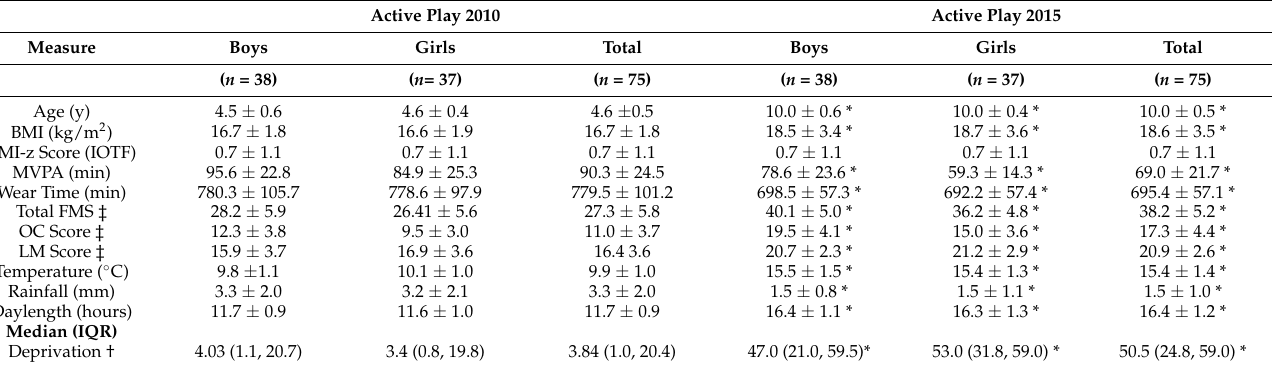
Table 1. Baseline (Active Play 2010) and Follow-Up (2015) descriptive characteristics for participants (Mean ± SD; Median and inter-quartile